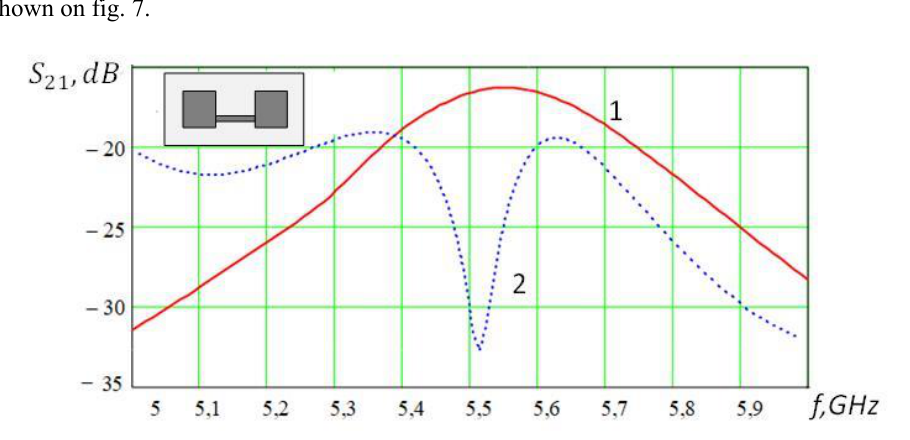
Fig. 7. Antenna with galvanic coupling between patches: 1 – reference antenna; 2 – antenna with transmission line. This device application increased coupling reduction more than 16 dB, but in narrower frequncy